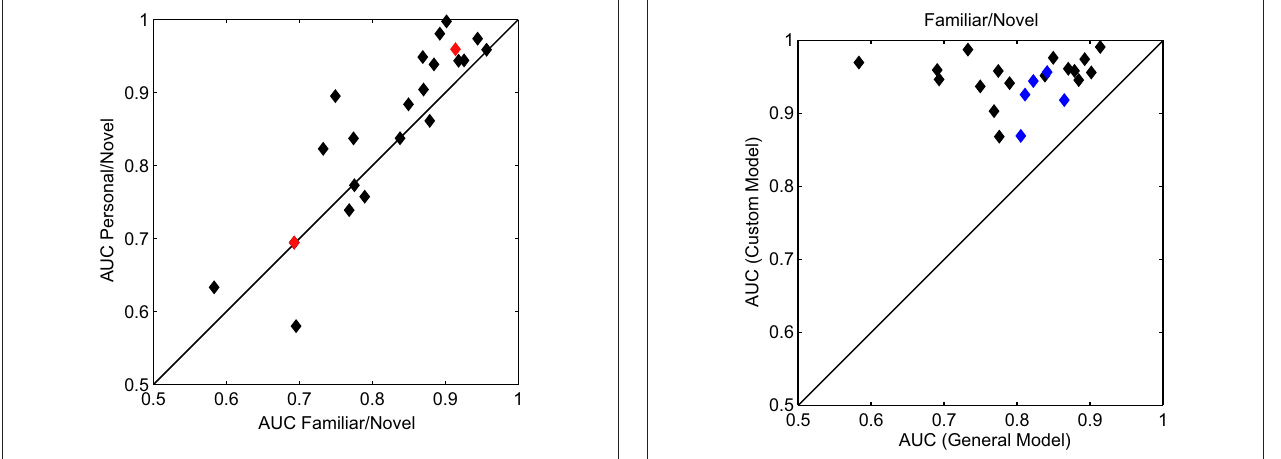
Figure 6 | receiver operating characteristics analysis of classifier models. Scatter plot of the AUC for each participant. All AUC values were calculated for the familiar (personal and famous) versus novel condition. The x and y axes represent the two model conditions: a general model (same for all participants) and a custom model (unique to each participant). Blue diamonds indicate the individual participants whose custom model was validated with a second, independent experimental